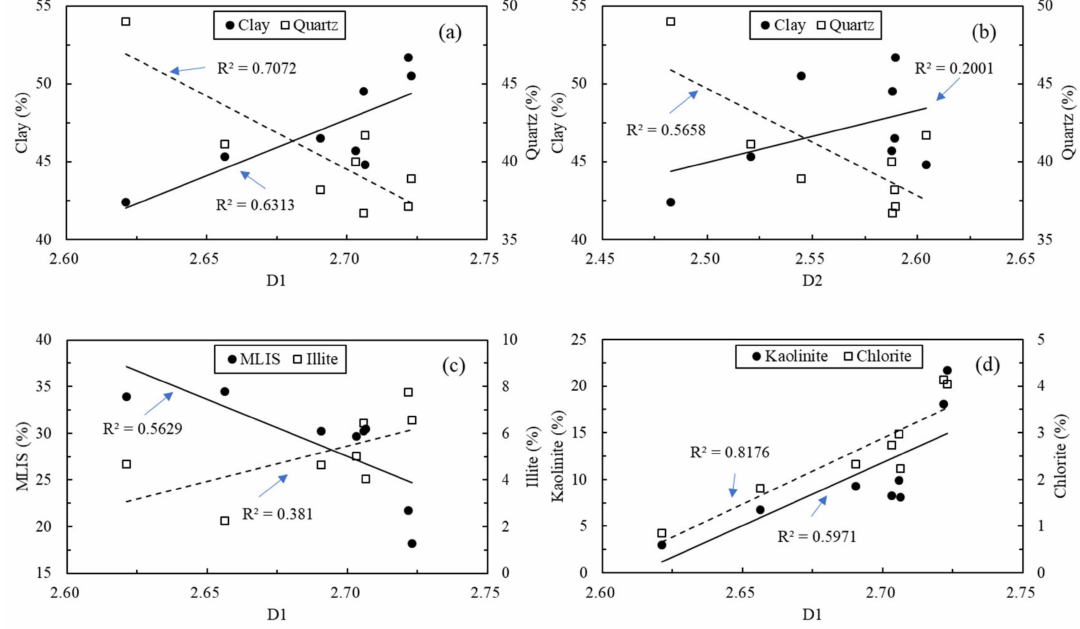
Figure 9. Relationships between shale component and fractal dimensions: ( a ) clay and quartz contents versus D1, ( b ) clay and quartz contents versus D2, ( c ) MLIS and illite contents versus D1, ( d ) kaolinite and chlorite contents versus D1.